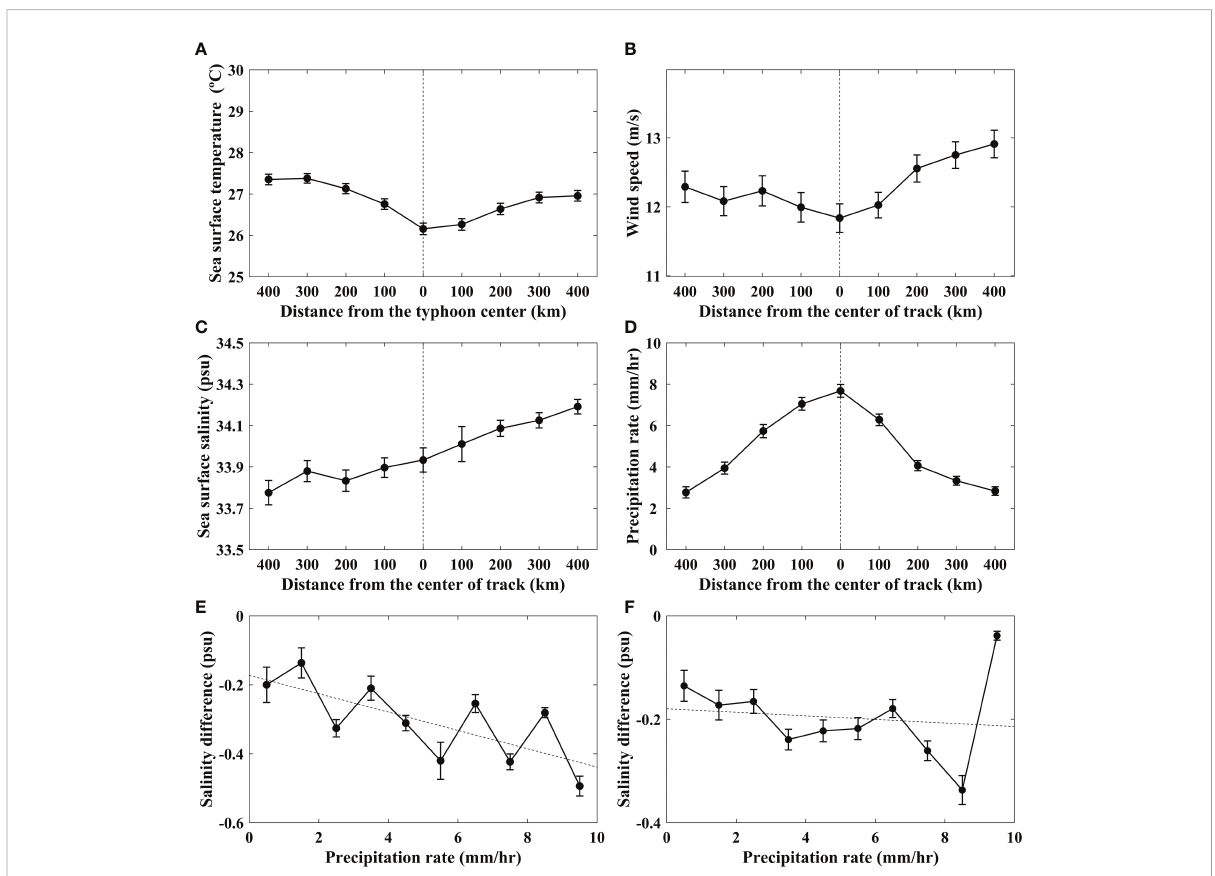
FIGURE 12 Distributions of (A) SST (°C), (B) wind speed (m s -1 ), (C) salinity (psu), and (D) precipitation rate (mm h -1 ) as a function of distance from a typhoon center in the Northwest Paci fi c. SSS difference (Aquarius – Argo) as a function of the maximum precipitation rate over time in (E) the left and (F) right side of each typhoon, where the error bar represents a mean error ( s = interval, and the dashed line represents a least-squared linear fi